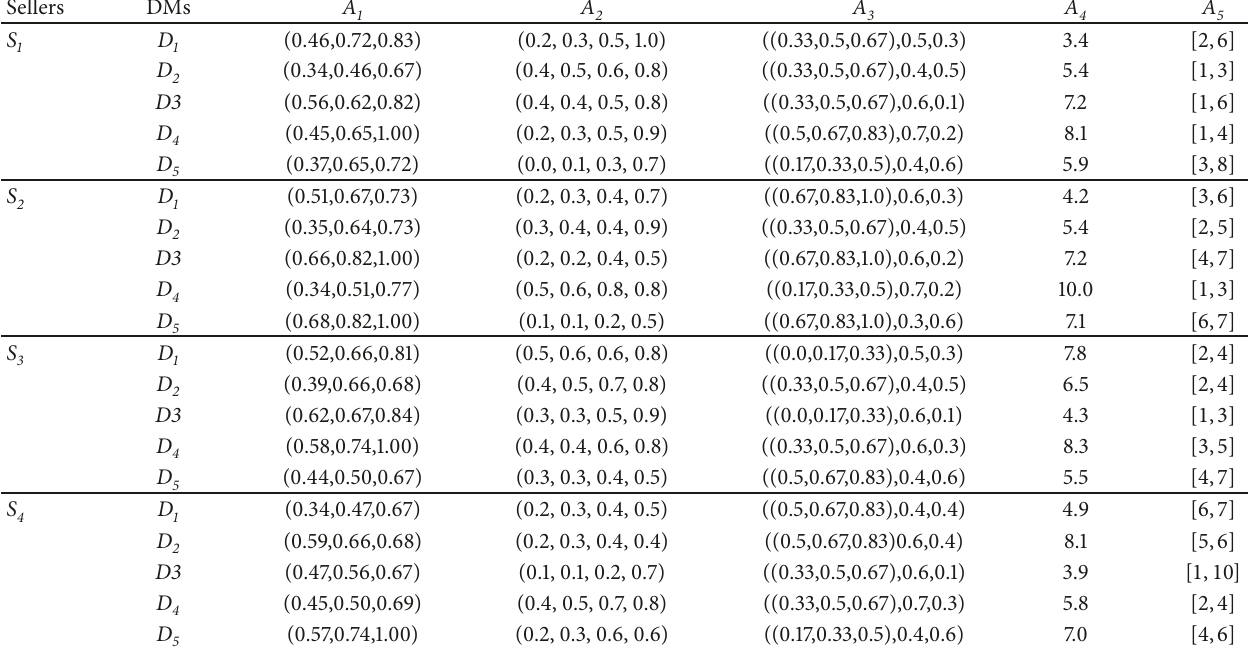
Table 1: The decision matrix of four